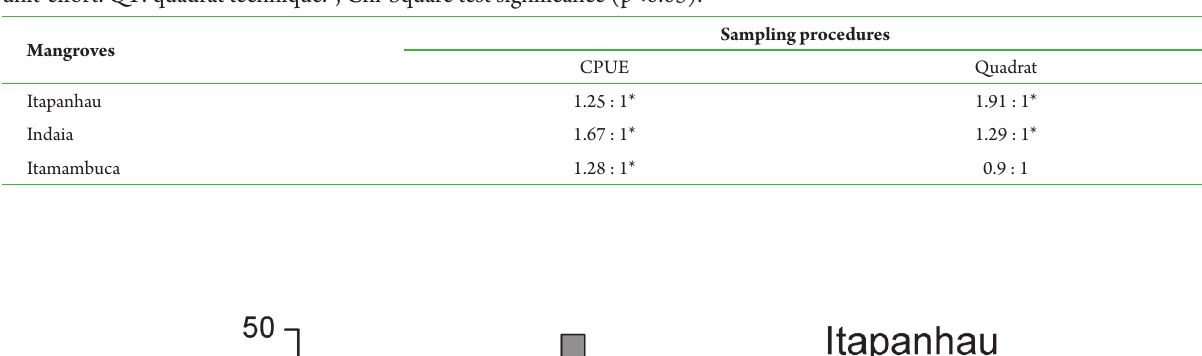
Table 1. Minuca vocator (Herbst, 1804). Sex ratio (males: females) in each mangrove and sampling procedure. CPUE: